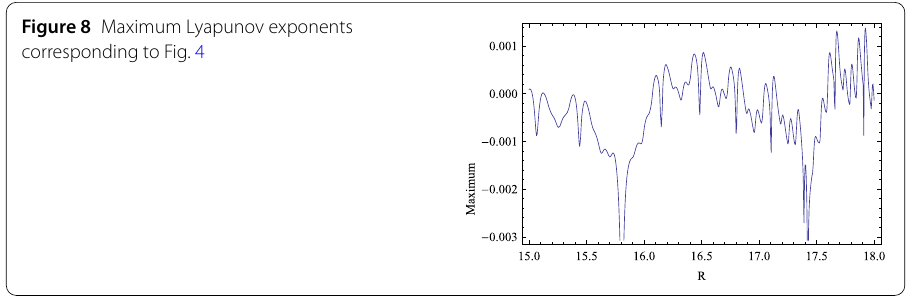
Figure 8 Maximum Lyapunov exponents corresponding to Fig.